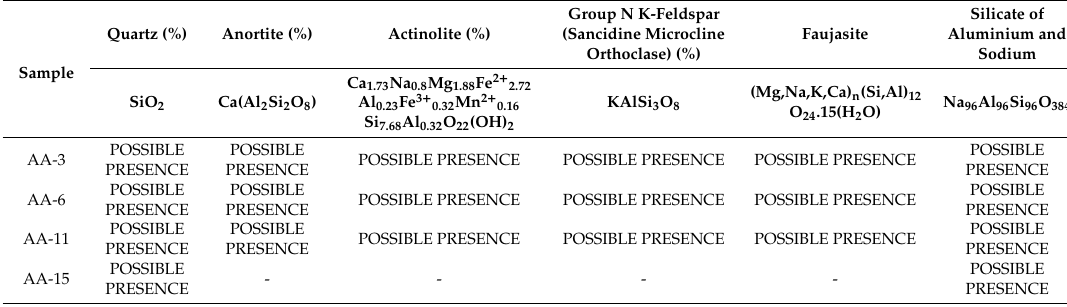
Table 12. Mineral determination by X-ray di ff raction of activated allophane.